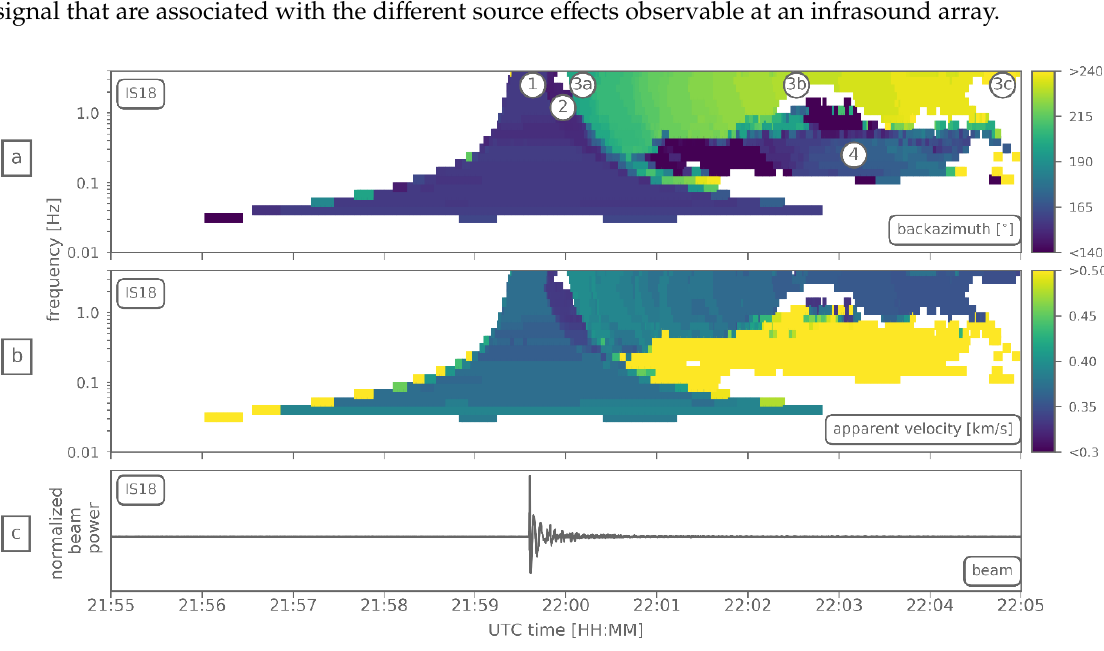
Figure 3. PMCC results for 10 min around the main signal arrival from the Greenland fireball at infrasound array IS18. ( a ) Backazimuth information between 0.02 and 4 Hz in a 100° angular segment towards the fireball location and trajectory. Different source effects are marked by numbers 1–4 (corresponding to the numbered list in the text). ( b ) Apparent velocity information as observed between the array elements. ( c ) Beam towards the main signal, bandpass-filtered from 0.2 to 4 Hz. The source effects, which are assigned to the signals in Figure 3 using the same labels, are 1.